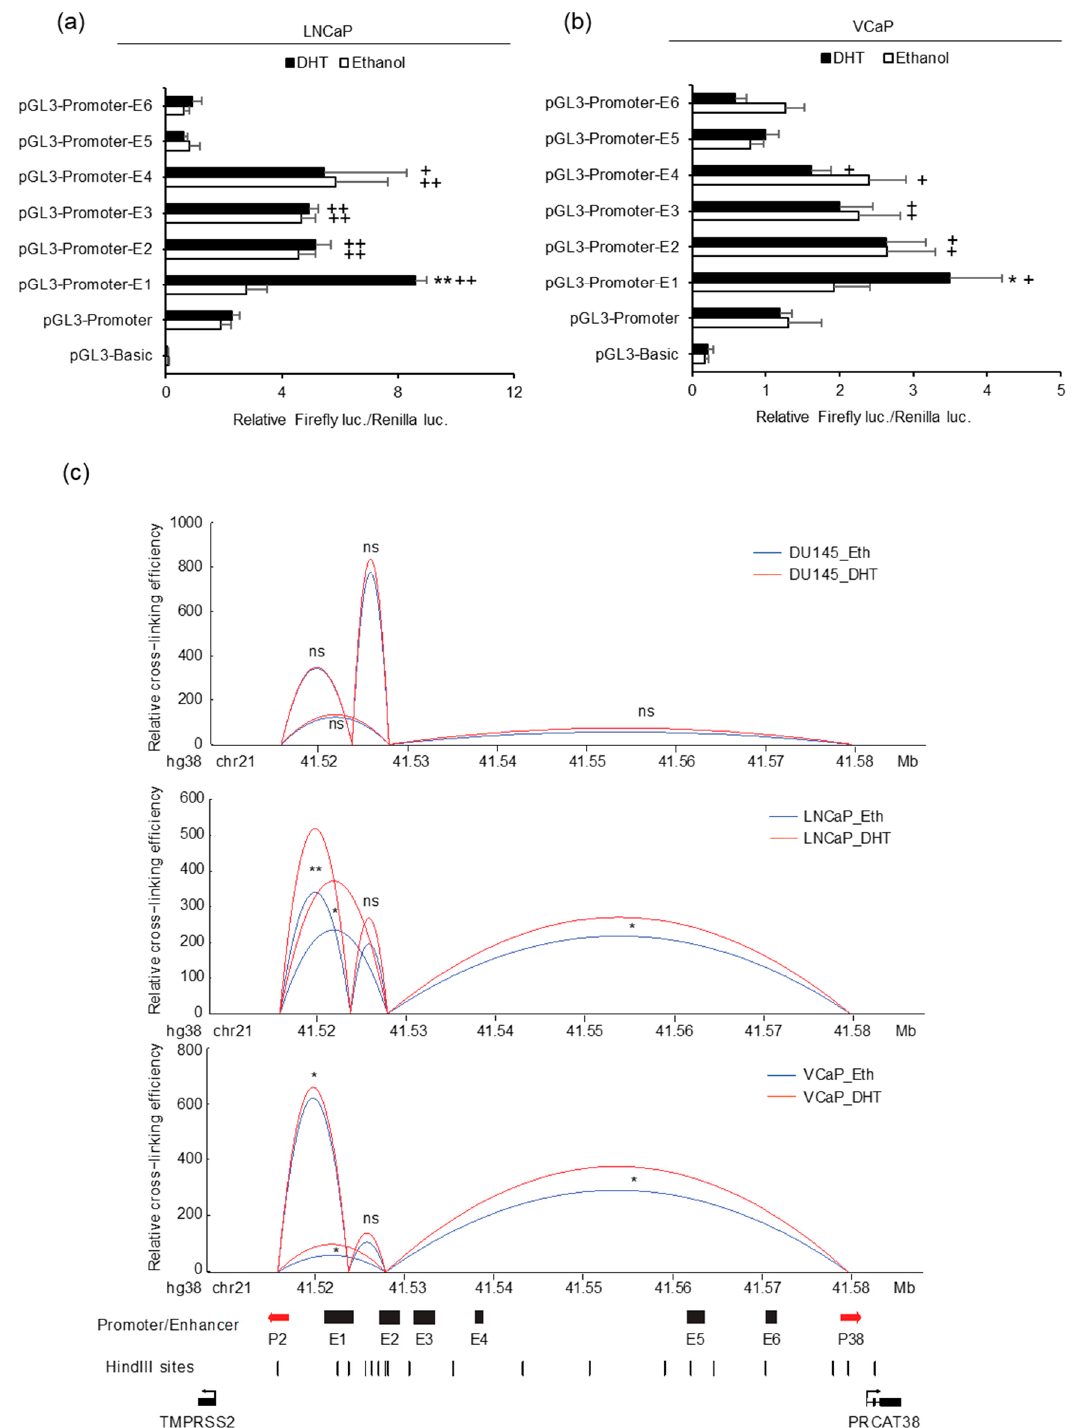
Figure 3. Enhancers E1 and E2 mediate TMPRSS2 and PRCAT38 gene regulation through chromatin looping. ( a – b ) Dual-luciferase reporter assays to determine enhancer activity in LNCaP and VCaP cells. Data are shown as mean ± SD (n = 3). * indicates a significant di ff erence between the vehicle and DHT treatment, + indicates a significant di ff erence between each construct and the pGL3-Promoter. ( c ) 3C-qPCR analysis revealing chromatin looping between enhancer regions and promoters of TMPRSS2 and PRCAT38 in DU145, LNCaP and VCaP cells (peak values of the loops are the mean of 3 biological replicates). * /+ : P < 0.05, ** /++ : P < 0.01, ns: not